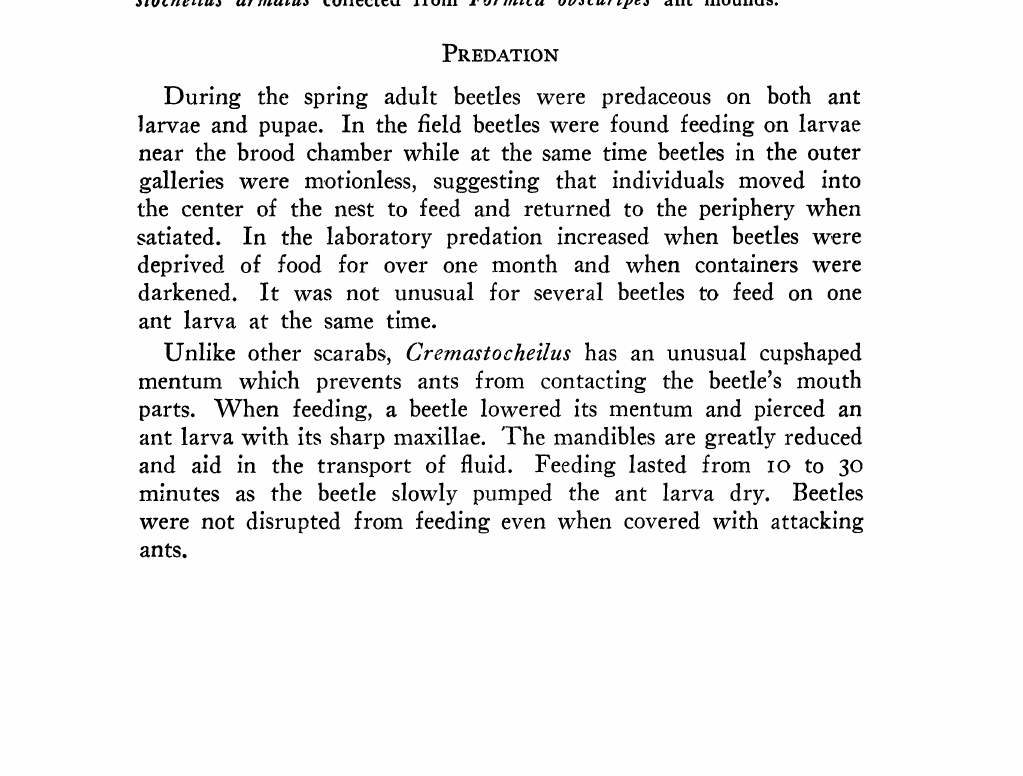
Figure 5. Seasonal distribution of the developmental stages of Crema- stocheilus armatus collected’ from Formica obscuries ant mounds.